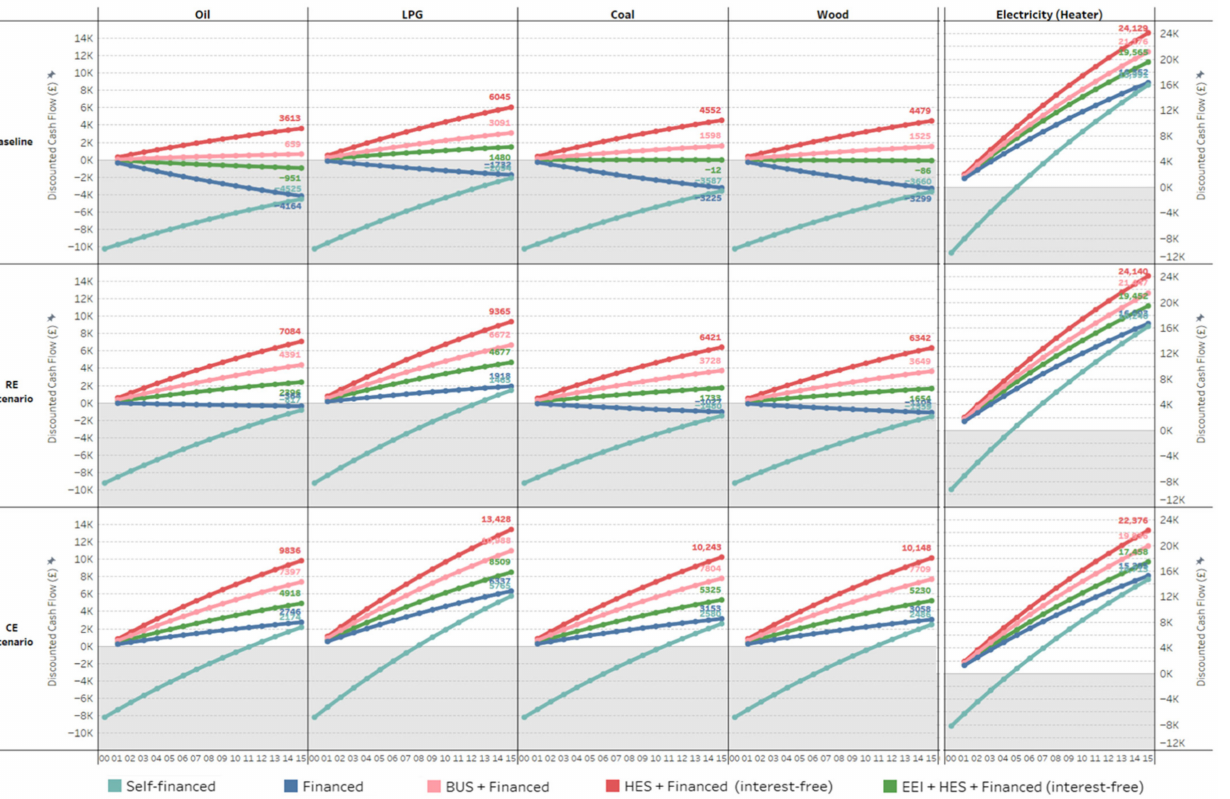
Figure 14. Cumulative lifetime costs of replacing heating technologies with heat pumps and different financial options for future scenarios (BUS: Boiler Upgrade Scheme Grant, HES: Home Energy Scotland Cashback, EEI: Energy Efficiency Improvement